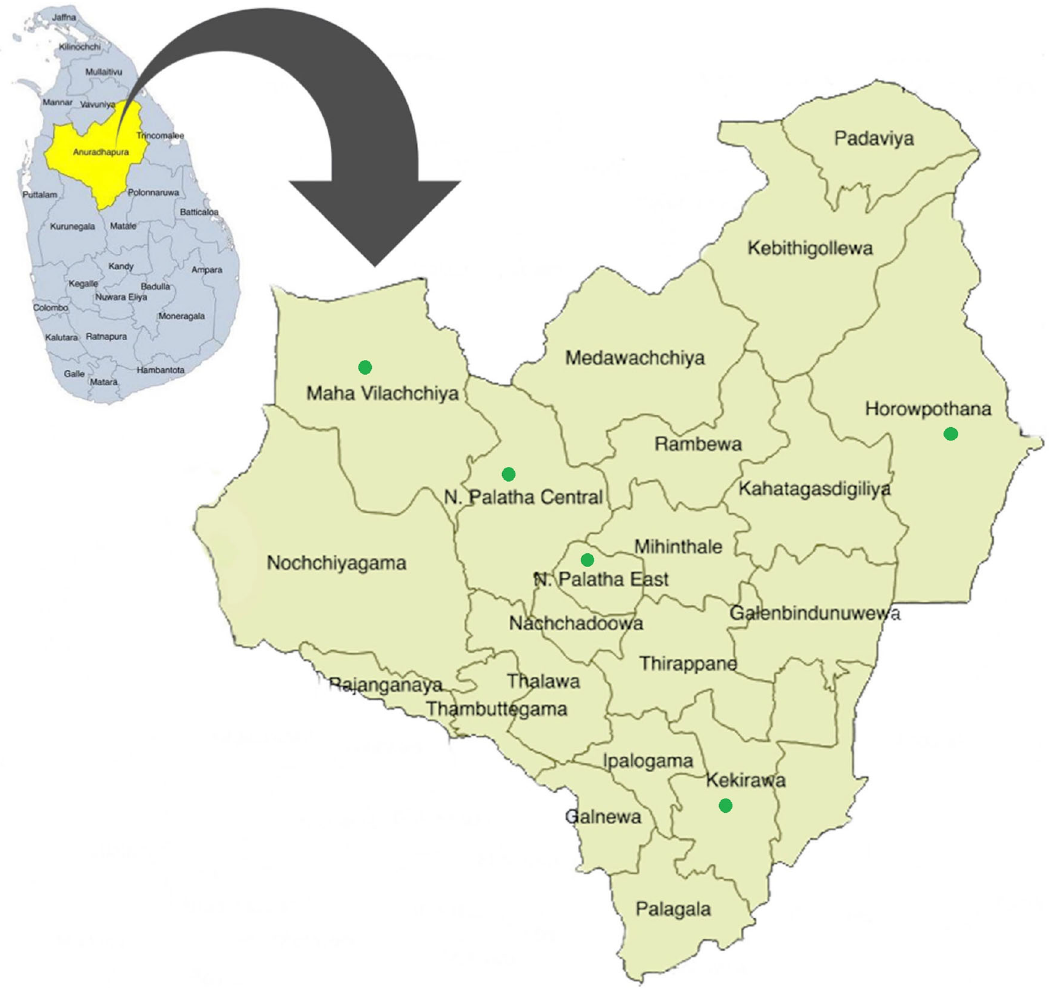
Figure1.Spatialdistributionof22participantrecruitmentareasofRaPCostudyintheAnuradhapuradistrict. (Thefigure hasbeenreproduced andeditedwiththepermission fromAgampodi TC,WickramasingheND,